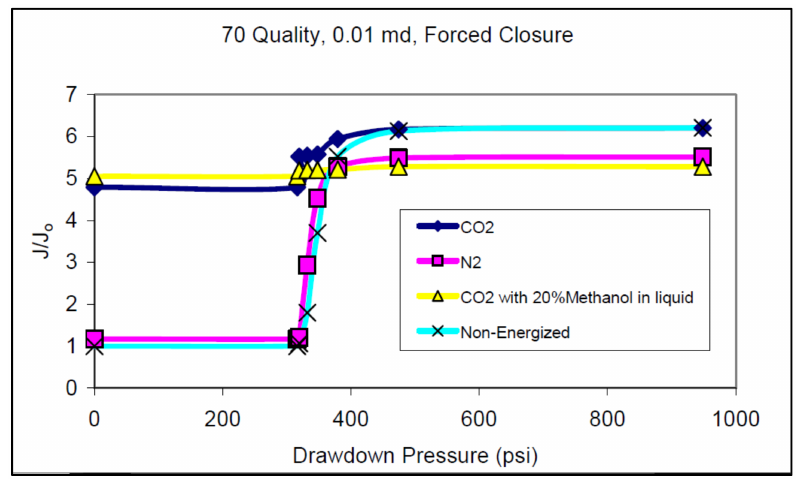
Figure 5. Productivity index against drawdown pressure of energized vs. non-energized fluid. (Reprinted with the permission from Friehauf & Sharma, [16]). Copyright 2010, Society of Petroleum